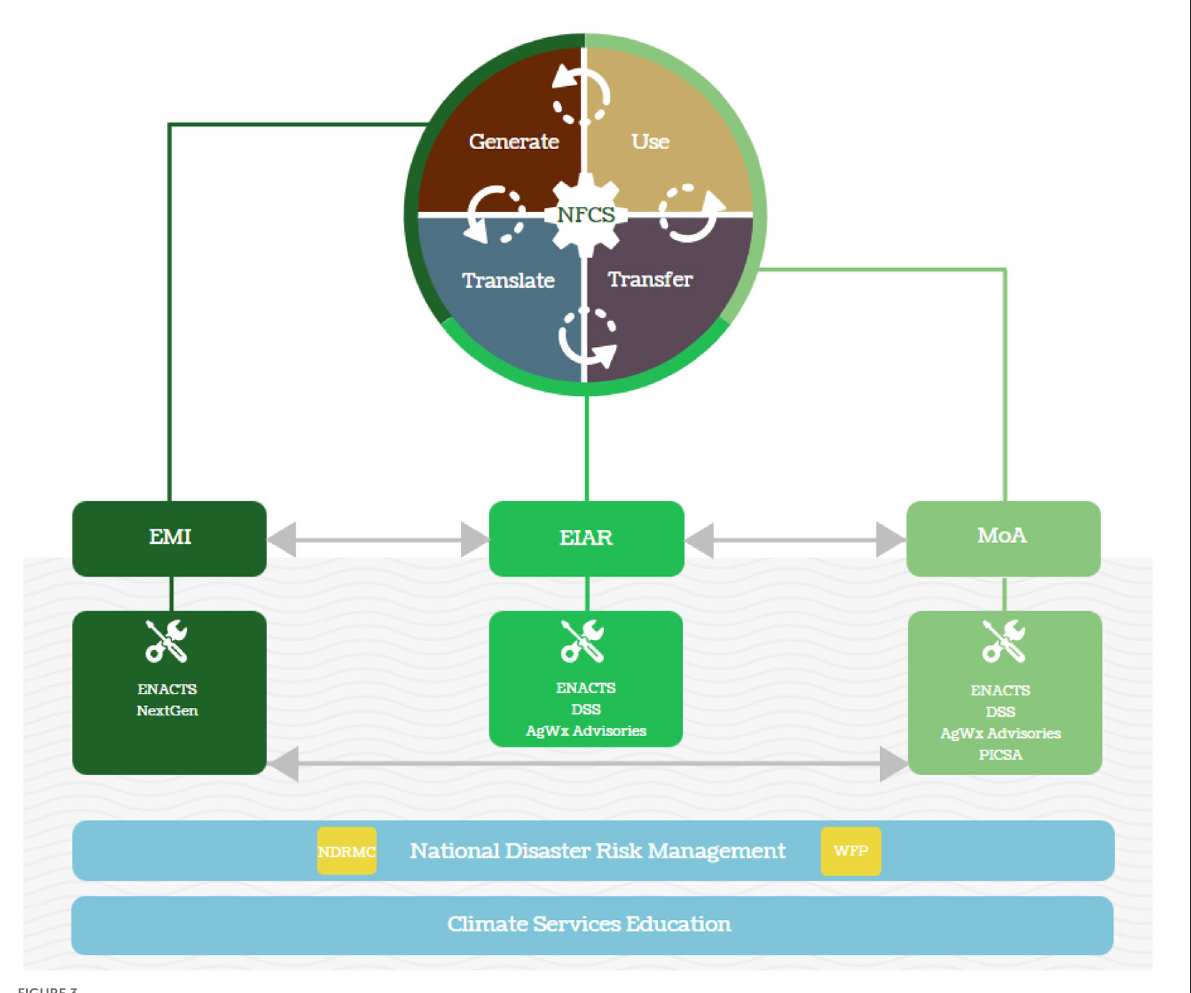
FIGURE3 ACToday core national partners in Ethiopia—The Ethiopian Meteorological Institute (EMI), Ethiopian Institute of Agricultural Research (EIAR), and Ministry of Agriculture (MoA)—and their relationship to the four pillars of climate services. The National Framework for Climate Services (NFCS) drives coordination of institutions and actions across each of these pillars, as depicted in the center of the wheel, while actions to support national disaster risk management and foundational capacity building and education on climate risk management are considered cross-cutting and support all pillars and